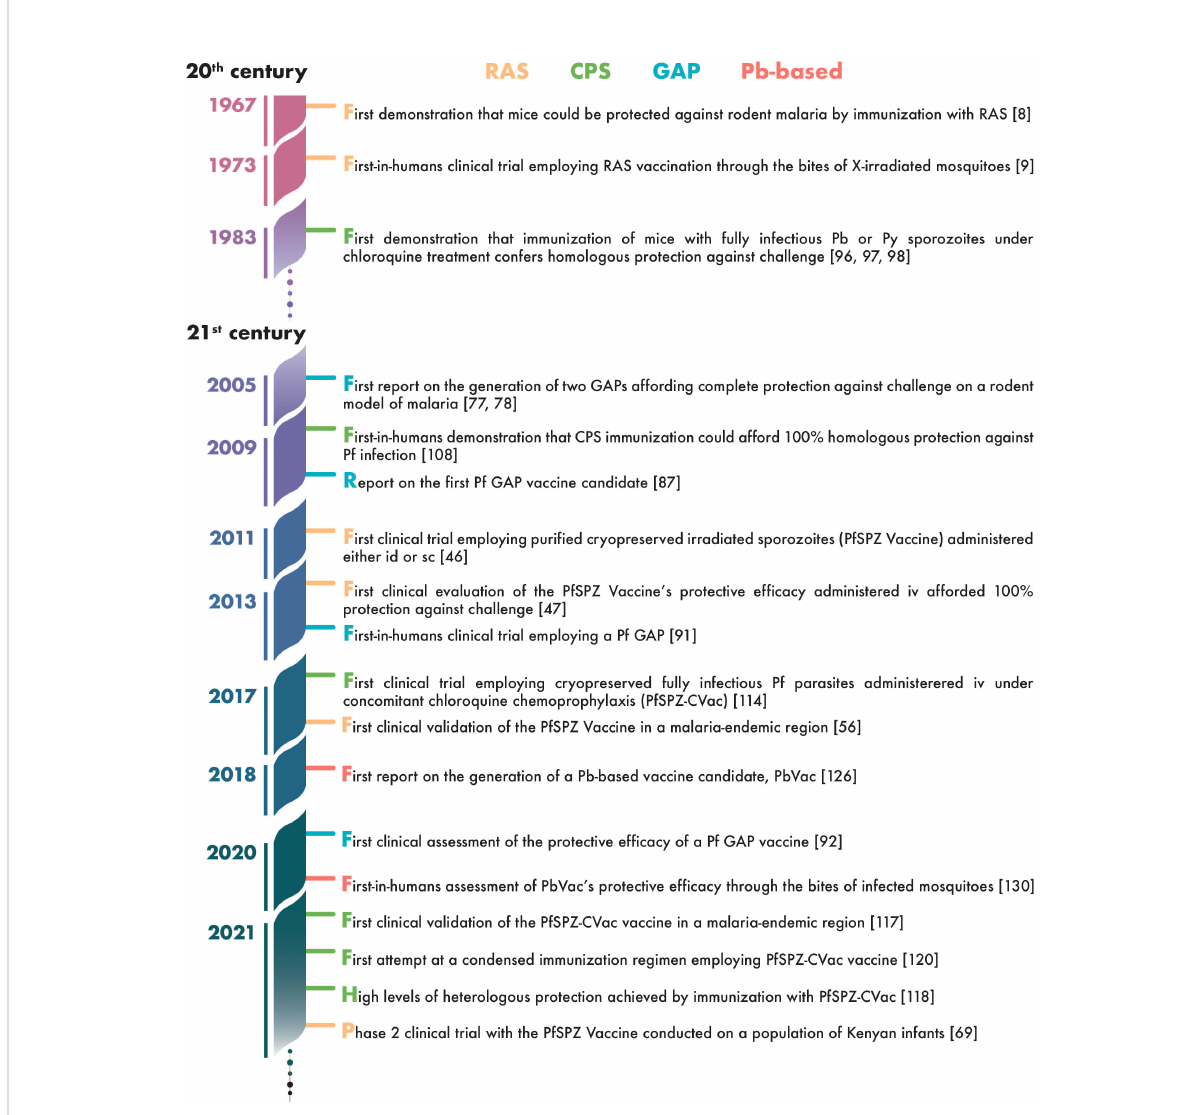
FIGURE 2 Timeline of landmark achievements in the development of whole-sporozoite vaccines against